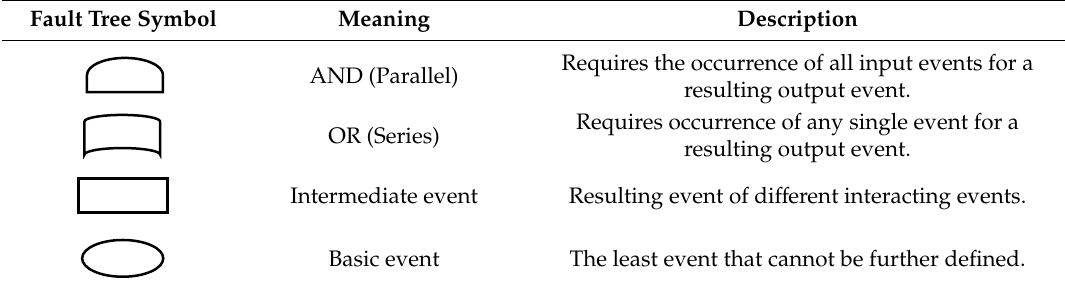
Table 1. Common fault tree analysis (FTA) gate symbols and their descriptions [27].